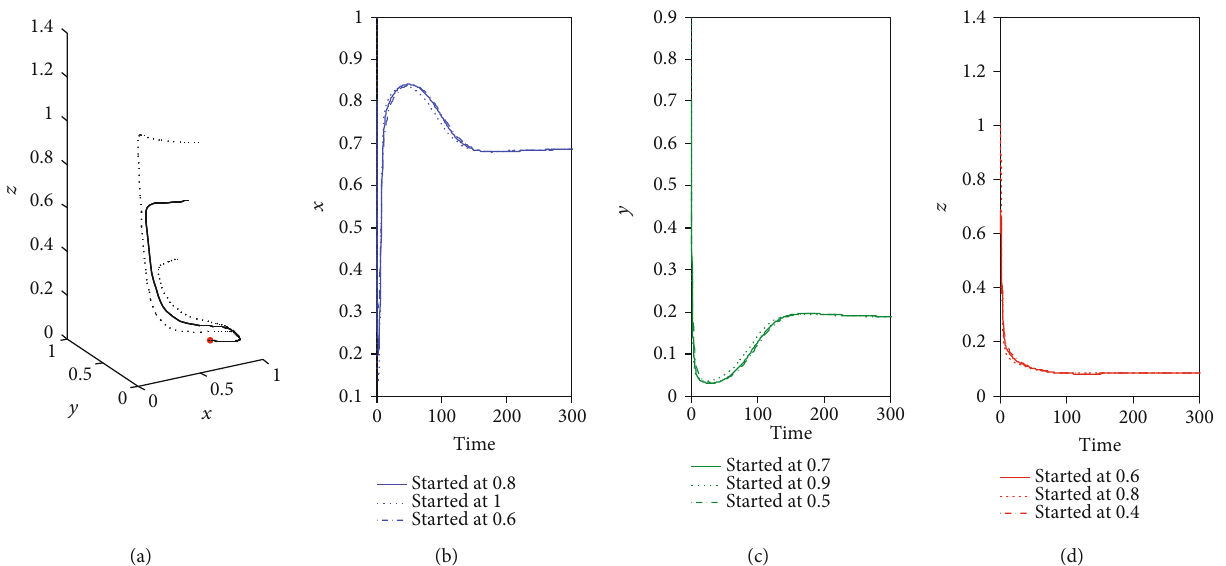
Figure 1: (a) The trajectories of system (4) approach asymptotically to CP, starting from di ff erent initial points with the data given by (89). (b) The trajectory of x versus t . (c) The trajectory of y versus t . (d) The trajectory of z versus t